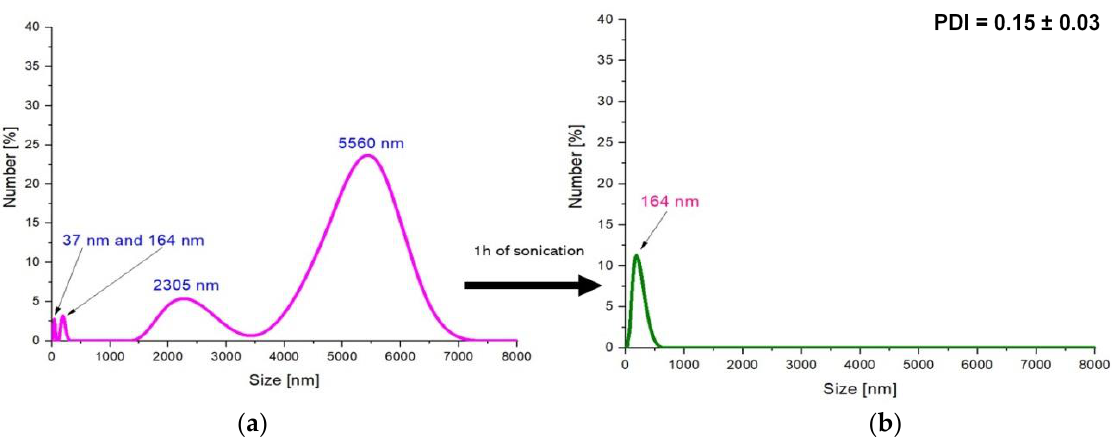
Figure 7. DLS measurements of the Fe 3 O 4 @Ag particles directly after the synthesis ( a ) and after 1 h of sonication ( b ) (PDI- polydispersity index).